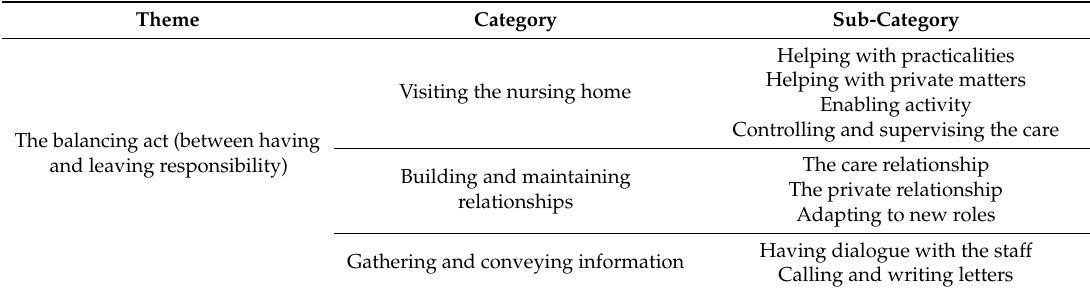
Table 2. The result presented in theme, categories, and